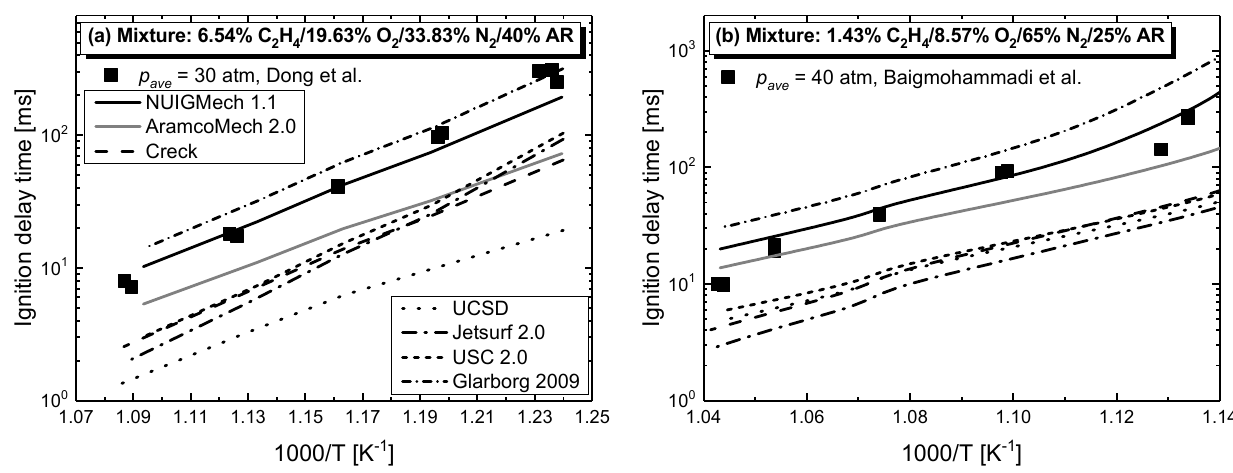
present studied conditions. However, Konnov 0.6 yields approximately 3.5 times lower values compared to present data for all of three pressures. As for the data obtained by Figure 6. Comparison of measured and simulated IDTs of ethylene with RCM at 30 atm ( a ) and 40 atm ( b ). Symbols: Figure 6. Comparison of measured and simulated IDTs of ethylene with RCM at 30 atm ( a ) and 40 atm ( b ). Symbols: RCM in Figure 8, again, both NUIGMech 1.1 and AramcoMech 2.0 predict fairly well the experiments from Dong et al. [29] and Badigmohammadi et al. [28], lines: model simulations. experiments from Dong et al. [29] and Badigmohammadi et al. [28], lines: model simulations. data, while all other models show poor performance and underestimate IDTs.